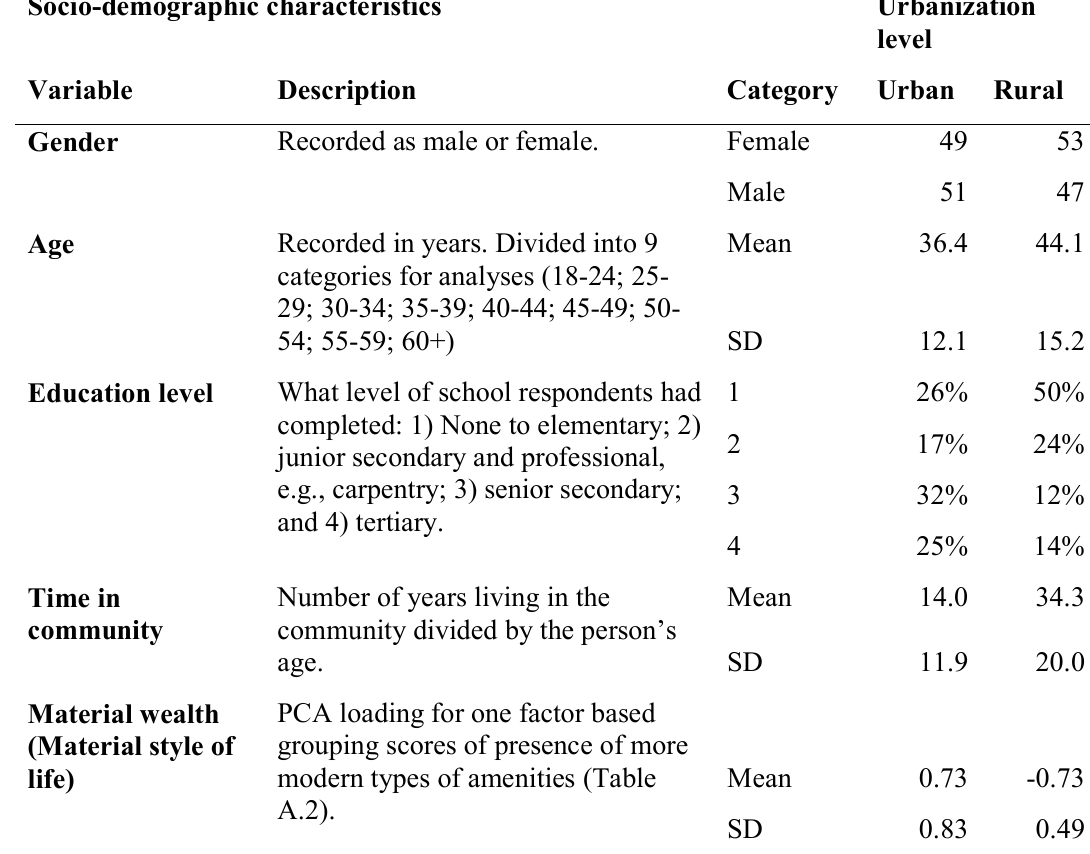
Table A.1. Comparisons of socio-demographic characteristics between urban and rural